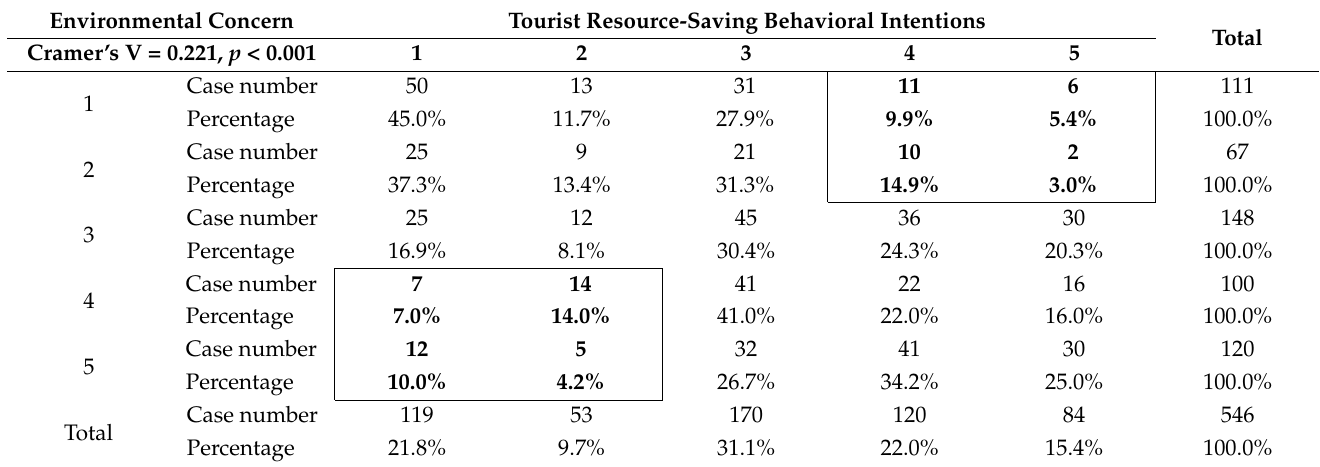
Table 8. Cross-contingency of environmental concern and tourist resource-saving behavioral intentions.